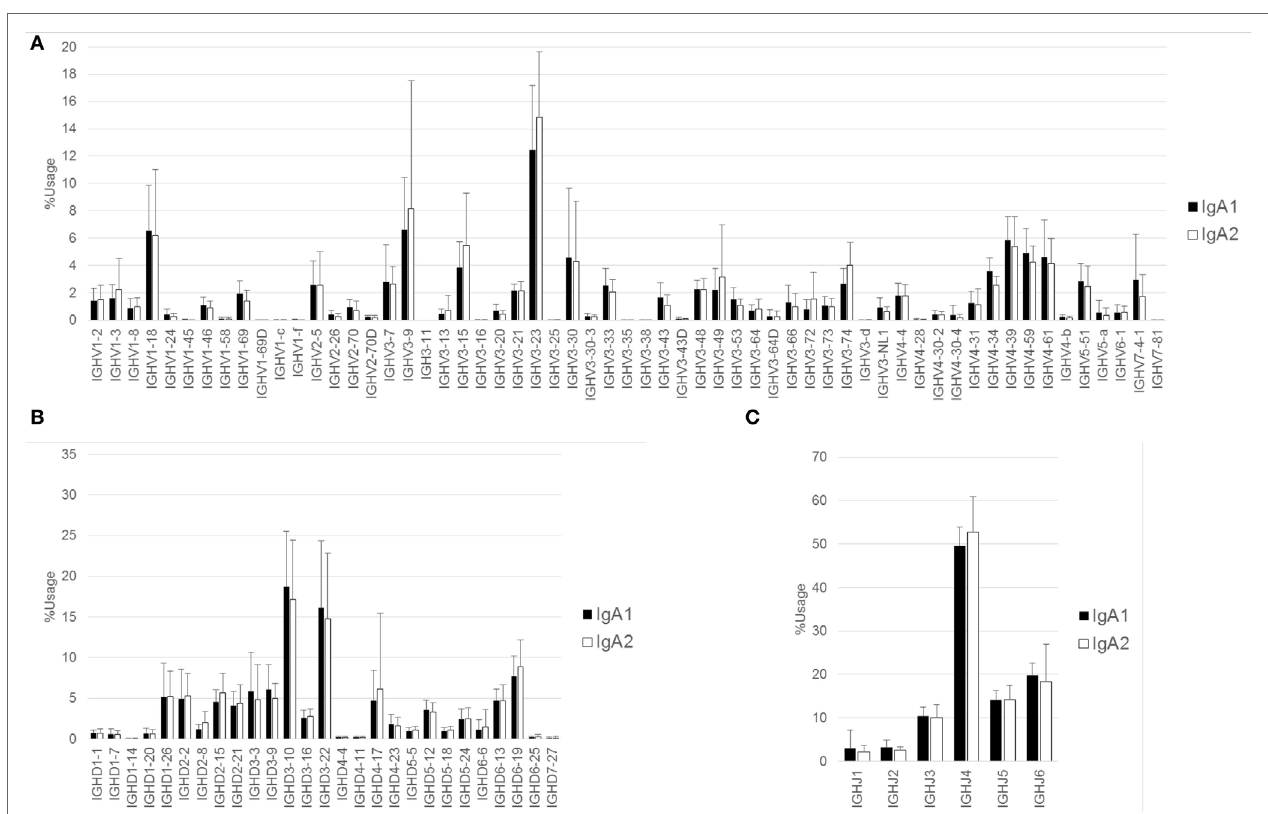
FigUre 3 | comparison of usage of ighV, ighD, and ighJ among iga subclasses . Mean percentage usages of IGHV (a) , IGHD (B) , and IGHJ (c) were compared between IgA1 and IgA2. Bars and error bars indicate mean percentage usage and SD of 12 healthy individuals, respectively. There were significant differences in IGHV3–35 ( P < 0.001), IGHV3–74 ( P < 0.05), and IGHV4–34 ( P <